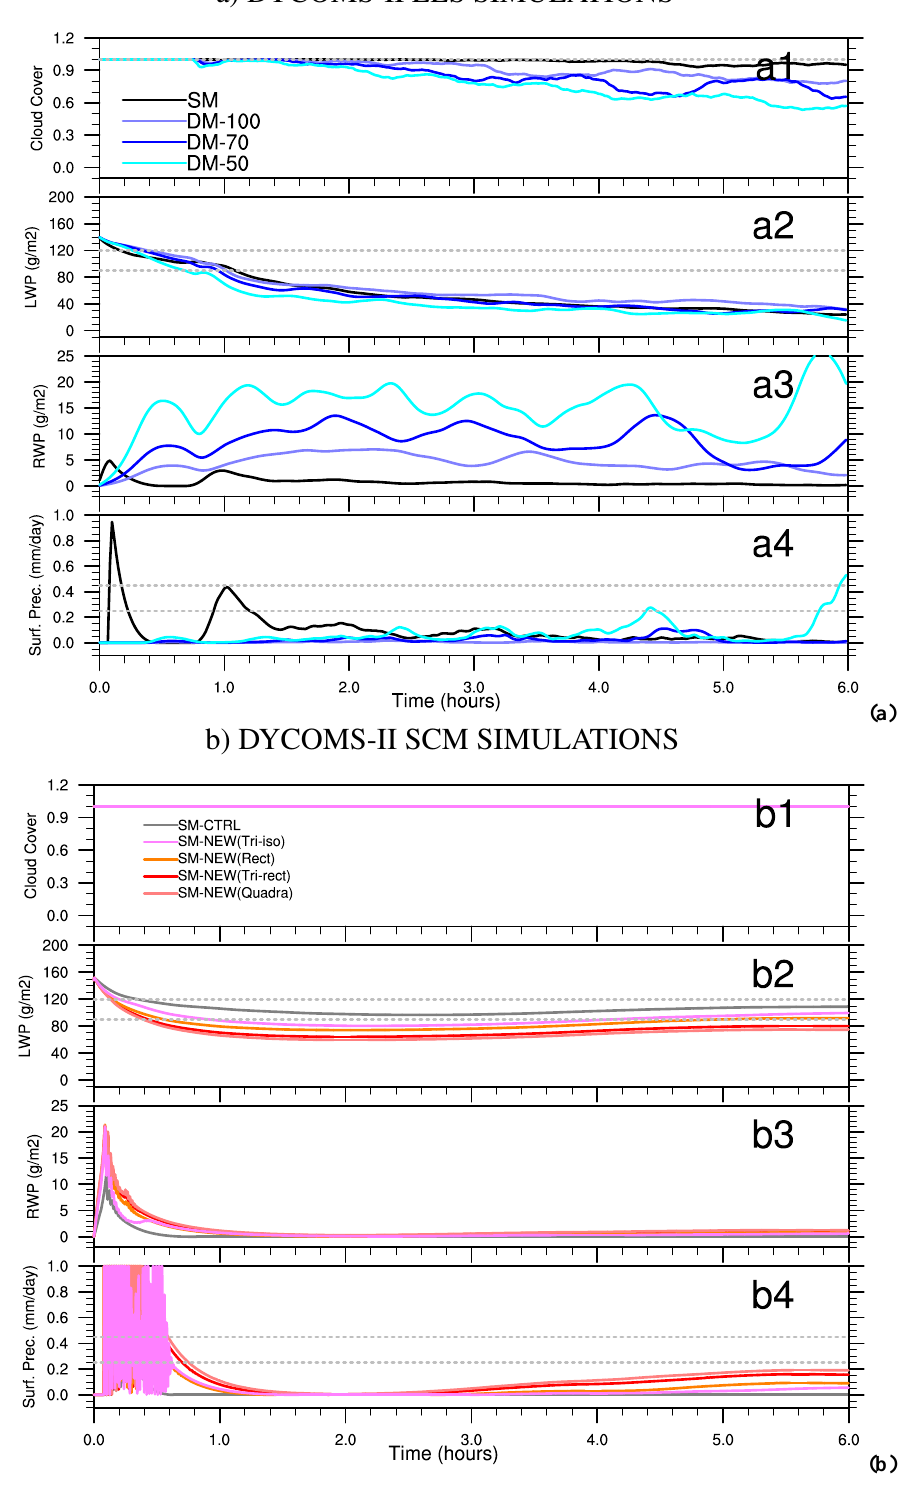
Figure 5: Mean temporal evolution over the entire domain for DYCOMS-II LES (a) and SCM (b) sim- ulations. From top to bottom: cloud cover, integrated cloud water content (LWP, g / m 2 ) and rain water content (RWP, g / m 2 ) and surface precipitation (Surf. Prec., mm / day ).